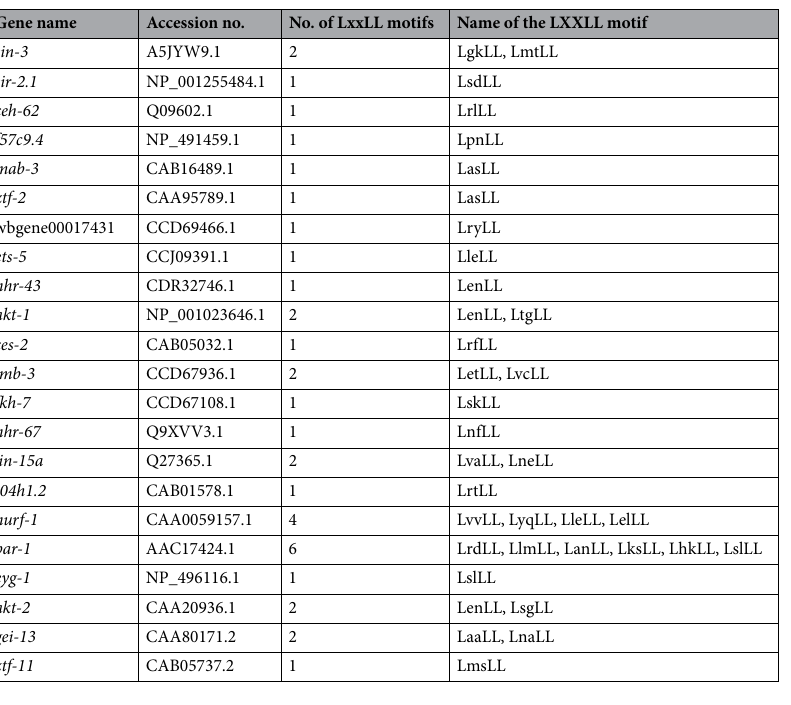
Table 5. Caenorhabditis elegans SIN-3 protein interactors containing LxxLL motifs. LxxLL motif is an acidic leucine (L)–rich protein binding motif used by proteins to interact with the PAH1 domain of SIN3 protein. The protein sequences were obtained from NCBI protein and Uniprot databases, and the motifs were scanned using the ScanProsite 106 tool.